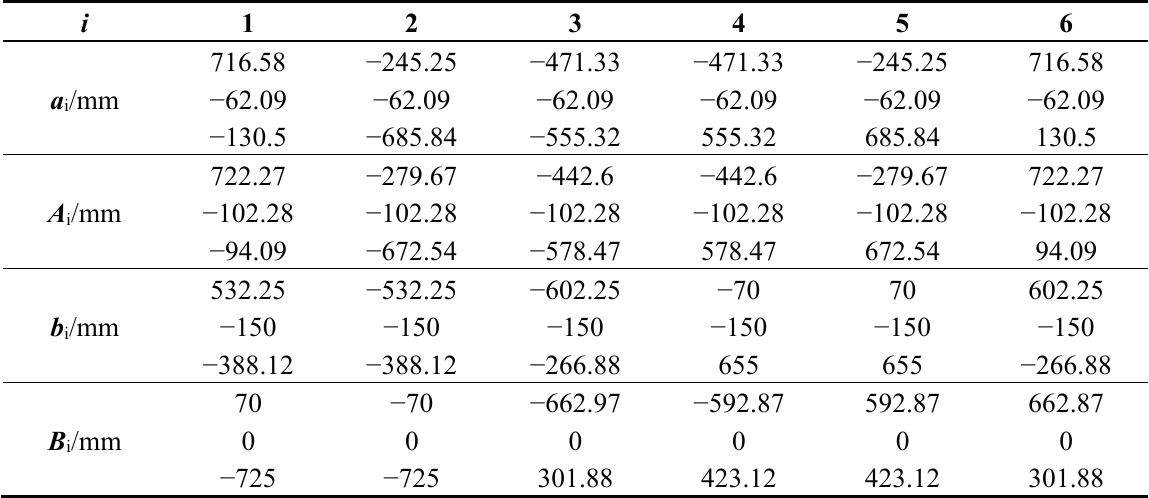
Table 1. The structure parameters of the low impact docking mechanism